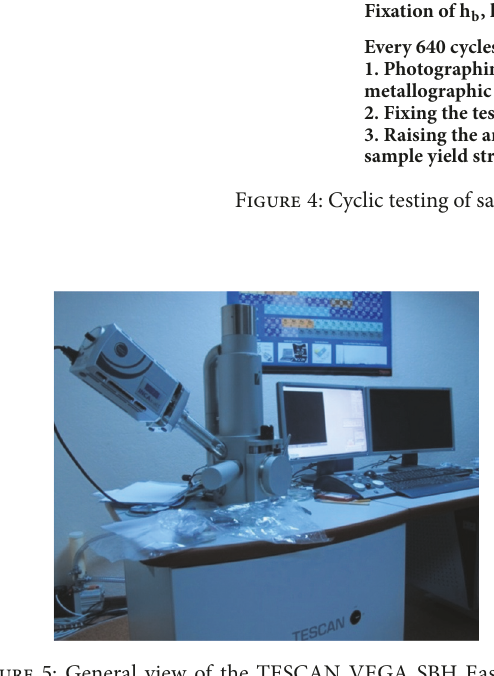
Figure 5: General view of the TESCAN VEGA SBH Easy Probe scanning electron